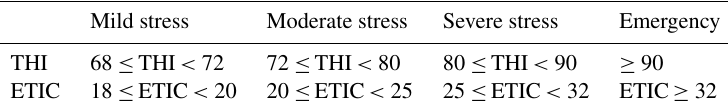
Table 5. Categories of heat stress levels used for our assessment. For temperature humidity index (THI) we used the thresholds defined by Collier based on milk-yield losses (Collier et al., 2012). For equivalent temperature index for cattle (ETIC) we used the thresholds defined by Wang based on a linear regression between THI and ETIC without wind ( v = 0ms − 1 ) and solar radiation (i.e., Q = 0Wm − 2 ) (Wang et al.,